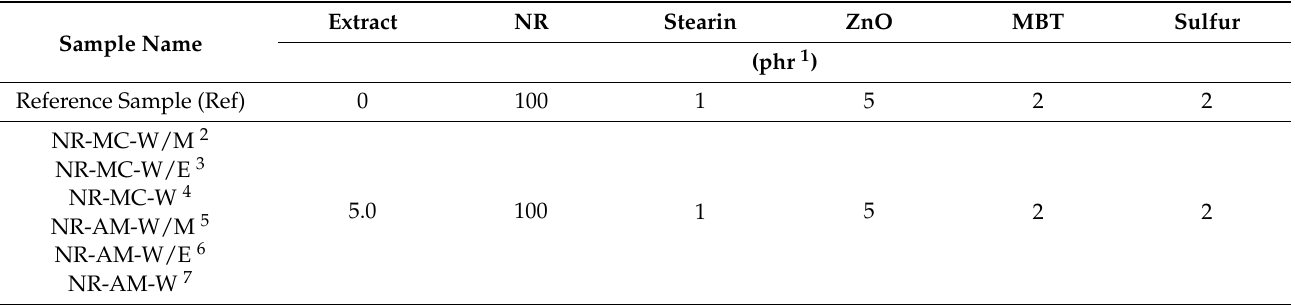
Table 7. Formulations of rubber